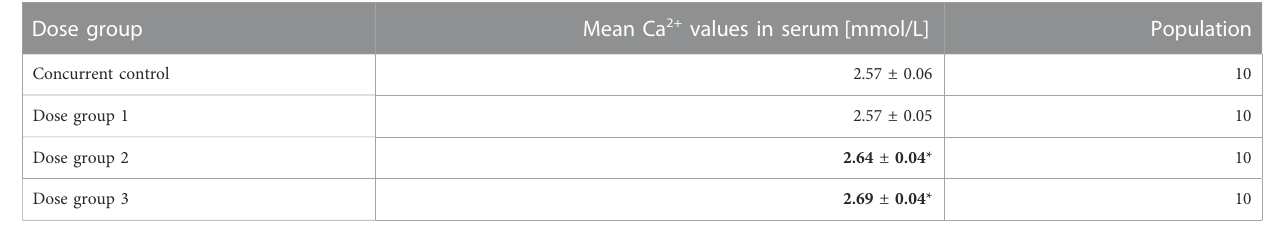
TABLE 1 Selected legacy study with the mean calcium levels in blood serum in each sex, the standard deviation, and the population. Dose group